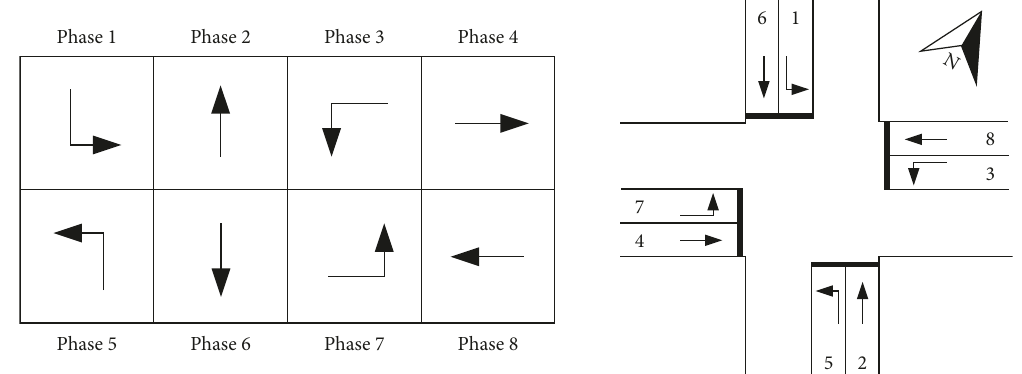
Figure 5: Ring-and-barrier